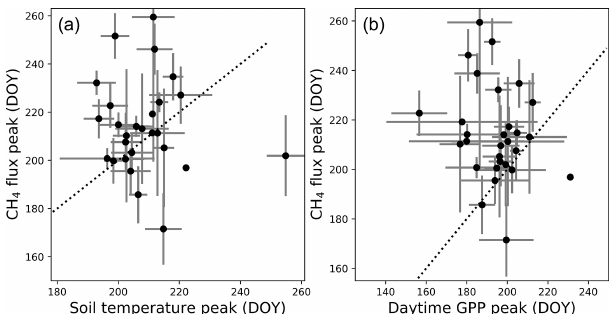
Figure A1. Peak methane (CH 4 ) flux timing versus peak gross pri- mary productivity (GPP) timing (a) and peak soil temperature tim- ing by day of year (b) . Points represent site average, and error bars represent standard deviations. Dotted line represents 1 : 1 relation-